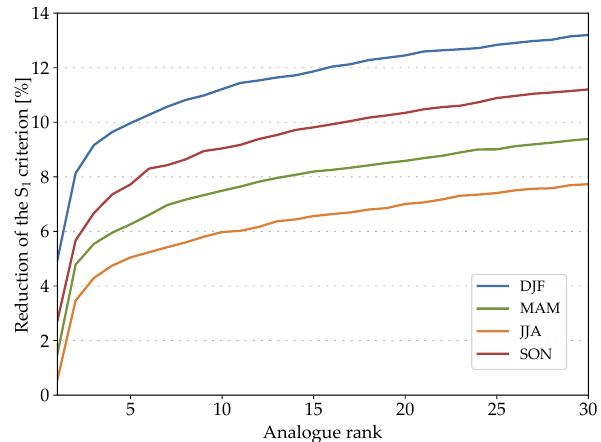
Figure 6. Seasonal effect on the median reduction of the S 1 crite- rion for the Ulrichen station due to the MTW. DJF: winter; MAM: spring; JJA: summer; SON: fall.